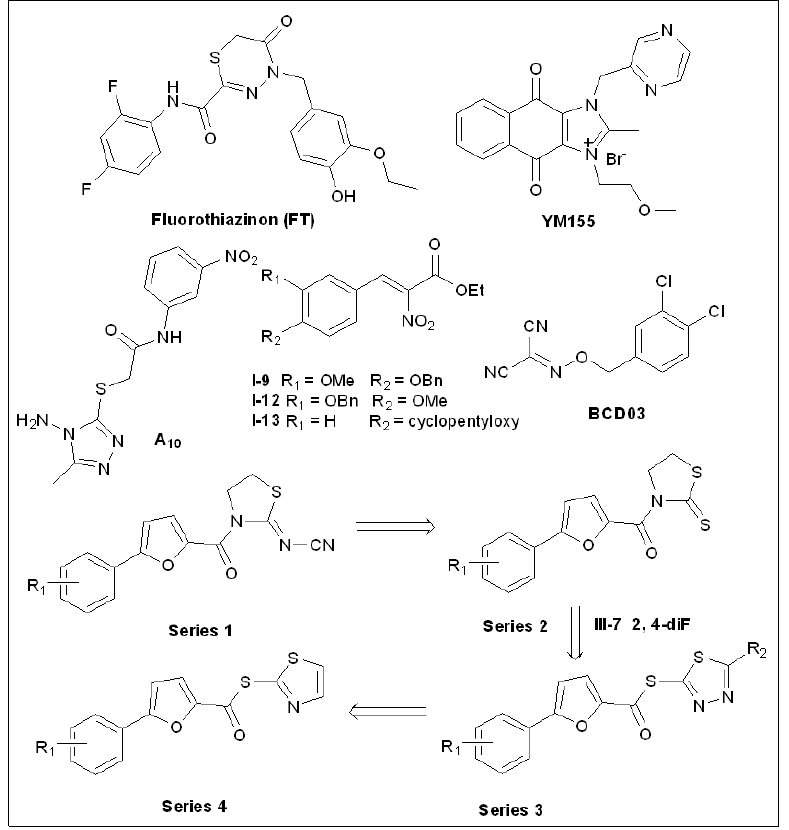
Figure 8. Structures of Fluorothiazinon (FT), YM155, A 10 , Thiazolidin derivatives and analogs, I − 9, I − 12, I − 13, and BCD03. I-12, I-13, and